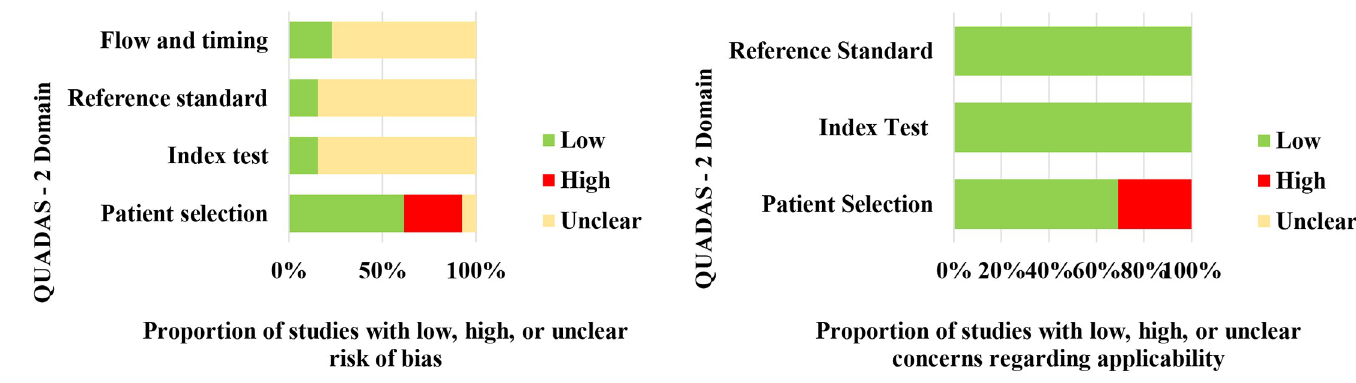
Fig 2. QUADAS-2 results showing risk of bias and applicability concerns of the studies selected.